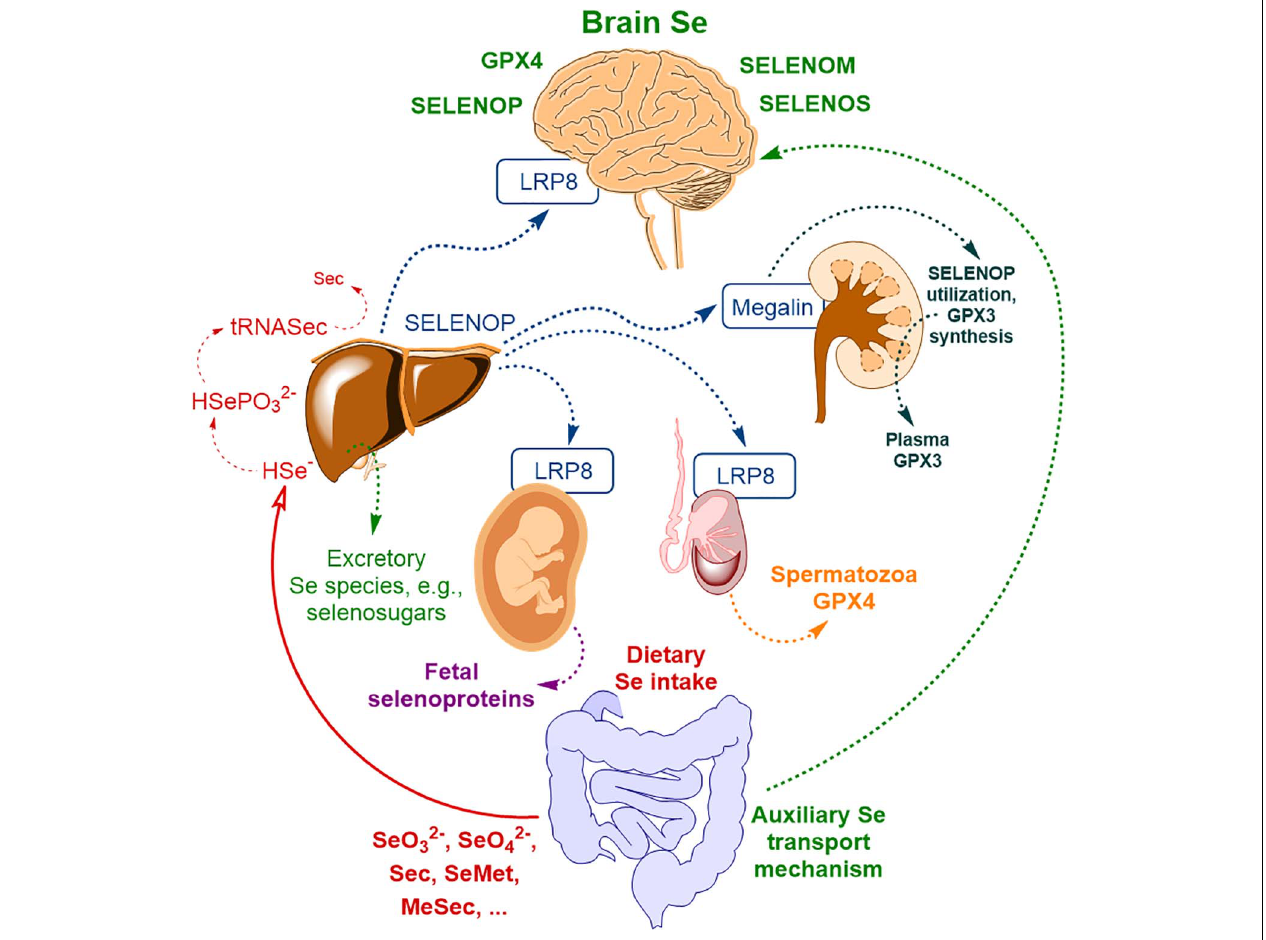
FIGURE 1 | The scheme of body Se homeostasis. Abbreviations: LRP8 – low-density lipoprotein receptor-related protein 8 (LRP8, also known as apolipoprotein E receptor-2, ApoER2), GPX3 – glutathione peroxidase type III, GPX4 – glutathione peroxidase type IV, Sec – selenocysteine, MeSec – methyl selenocysteine, SELENOM – selenoprotein M, SELENOP – selenoprotein P, SELENOS – selenoprotein S; * – auxiliary brain Se transport mechanism, independent of SELENOP, possibly related to selenosugars (Burk and Hill, 2015) and other low molecular weight Se-species (Solovyev et al., 2013) and possibly other minor contributors (please, see text for more detail). Based on Solovyev et al. (2018) with